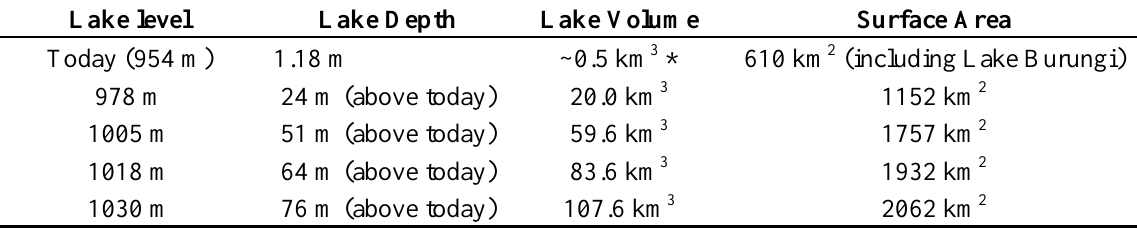
Table 2. Statistical evaluation of Lake Manyara paleolake